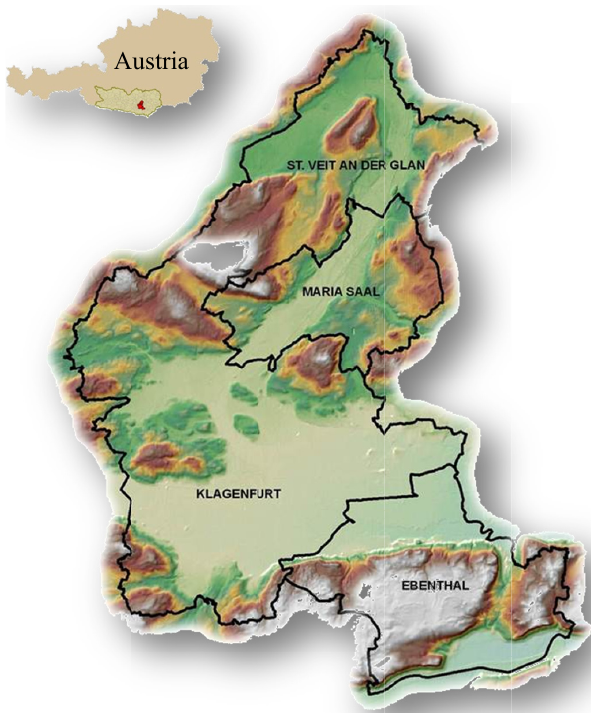
Fig. 1. Study area in Carinthia